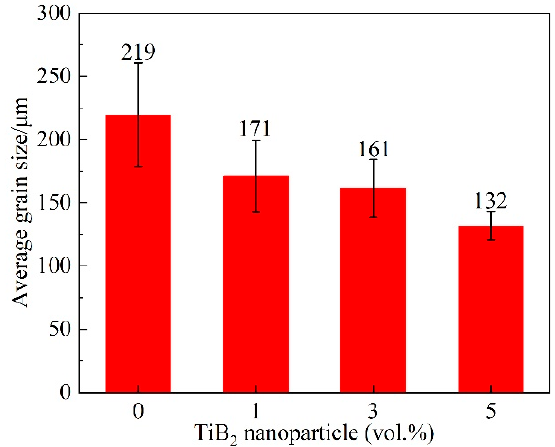
Figure 7. Variation of average grain size with vol.% of TiB 2 nanoparticles.